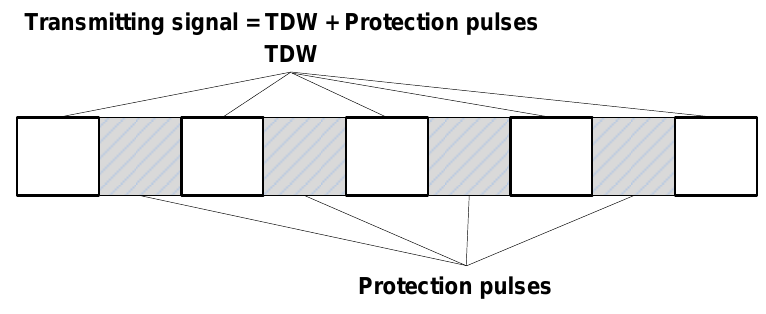
Figure 3. Structure of transmitting waveform for ISRJ suppression.